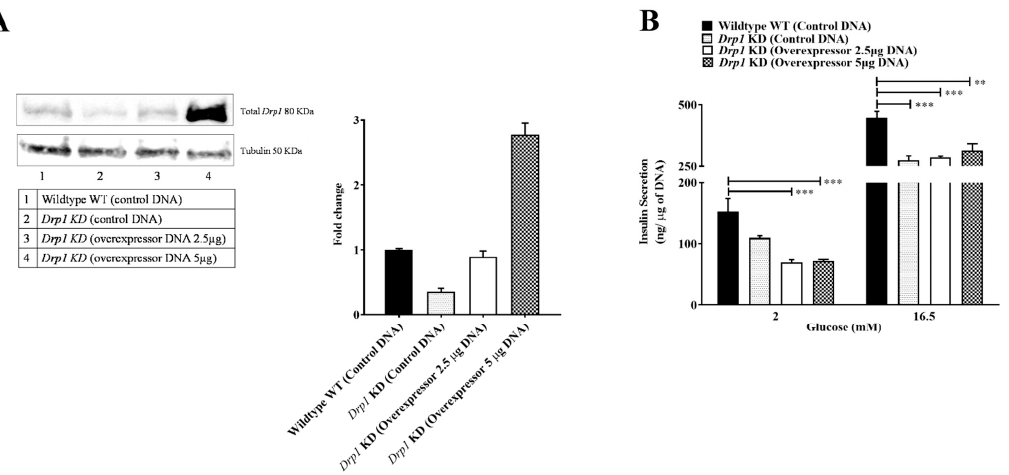
Figure 1. Insulin secretion of Drp1 -KD MIN6 cells overexpressing Drp1 . Drp1 -KD MIN6 cells were transiently transfected with Drp1 -containing plasmid using electroporation . ( A ) Immunoblot and densitometric quantification of overexpressed Drp1 . Data are represented as mean ± SEM ( n = 3) ( B ) Insulin release is expressed as nanograms of insulin per microgram of DNA. Data are presented as mean ± SEM ( n = 4), and n -values represent independent experiments. The statistical